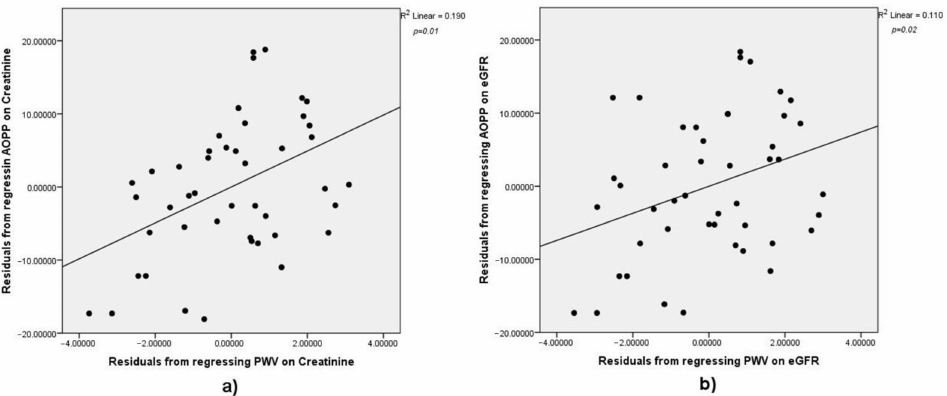
Figure 3. Scatterplots illustrating the positive correlation between PWV (m/s) and AOPP ( µ mol/L) after adjusting for the effect of serum creatinine ( a ) and eGFR ( b ). As shown by the differences in the r-value, serum creatinine improved the relationship between AOPP and PWV more than eGFR. Legend: PWV = pulse wave velocity; AOPP = advanced oxidation protein products; eGFR = estimated glomerular filtration